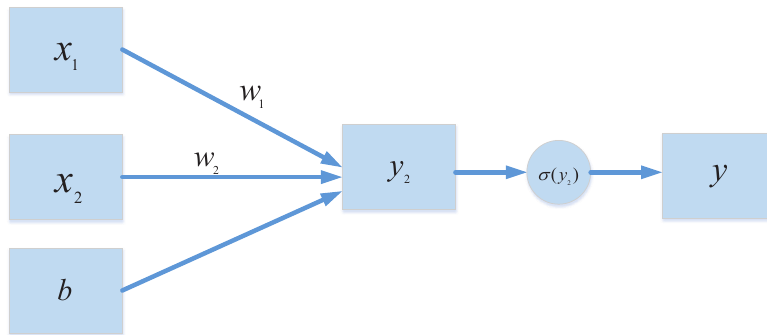
Figure 3. A single layer perceptron with an activation